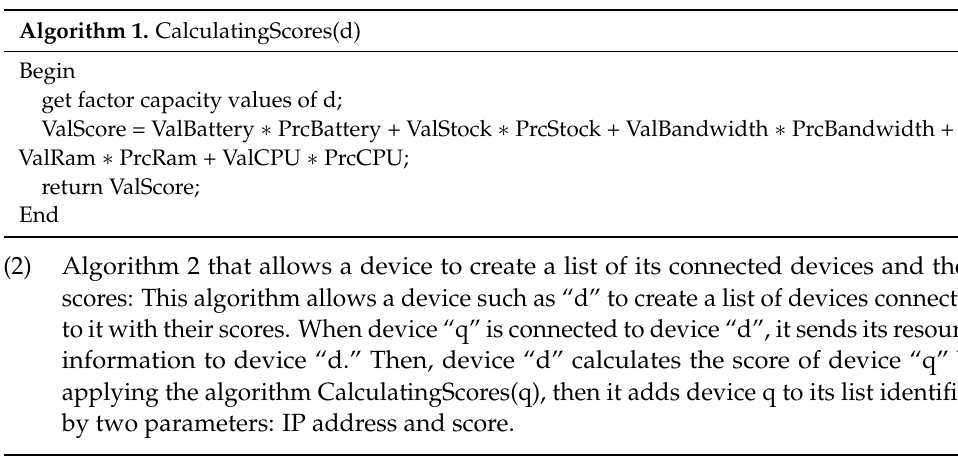
Algorithm 2. Creating_List_Devices_Scores(d)